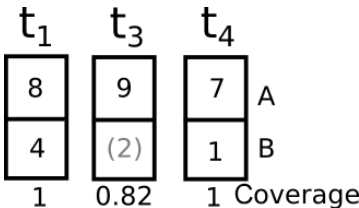
Figure A2. Schematic demonstrating coverage. Velocities are filled with linear interpolation in time, and coverage is weighted by dis- charge. t columns represent the same two gate pixels (A and B) at three time steps, where t n are linearly spaced, but t 2 is not observed anywhere on the ice sheet and is therefore not included. Numbers in boxes represent example discharge values. Gray parenthetical num- ber is filled, not sampled, in pixel B at time t 3 . Weighted filling computes the coverage as 9 / 11 = 0 . 81, instead of 0.5 (half of the pixels at time t 3 have